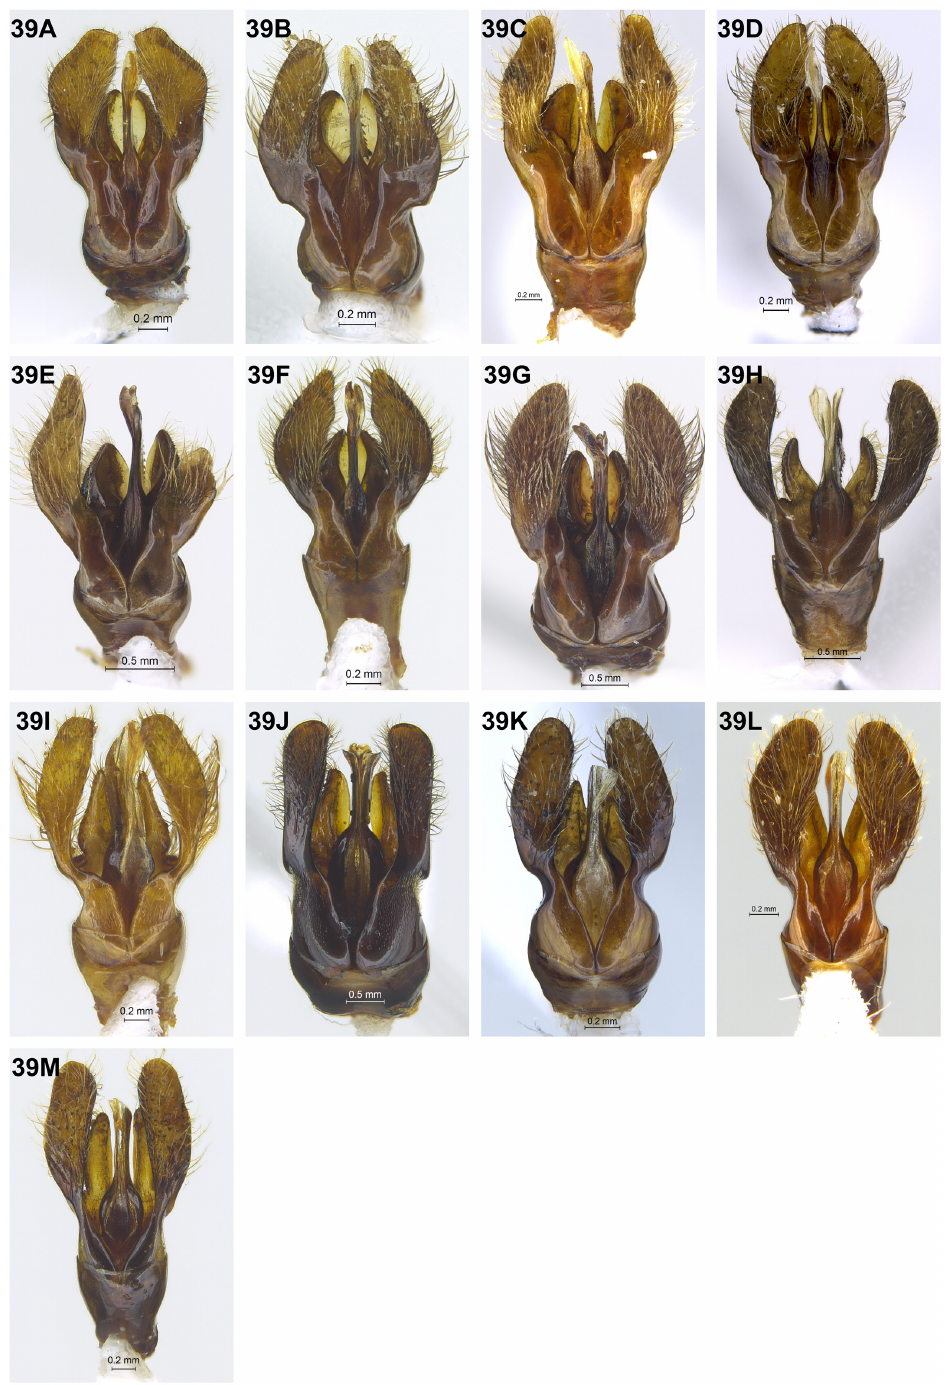
Fig. 39. Males genital capsule, dorsal view. A . Campsomeriella annulata annulata (Fabricius, 1793). B . Camps. collaris (Fabricius, 1775). C . Megacampsomeris sp. 1. D . Megacam. formosensis